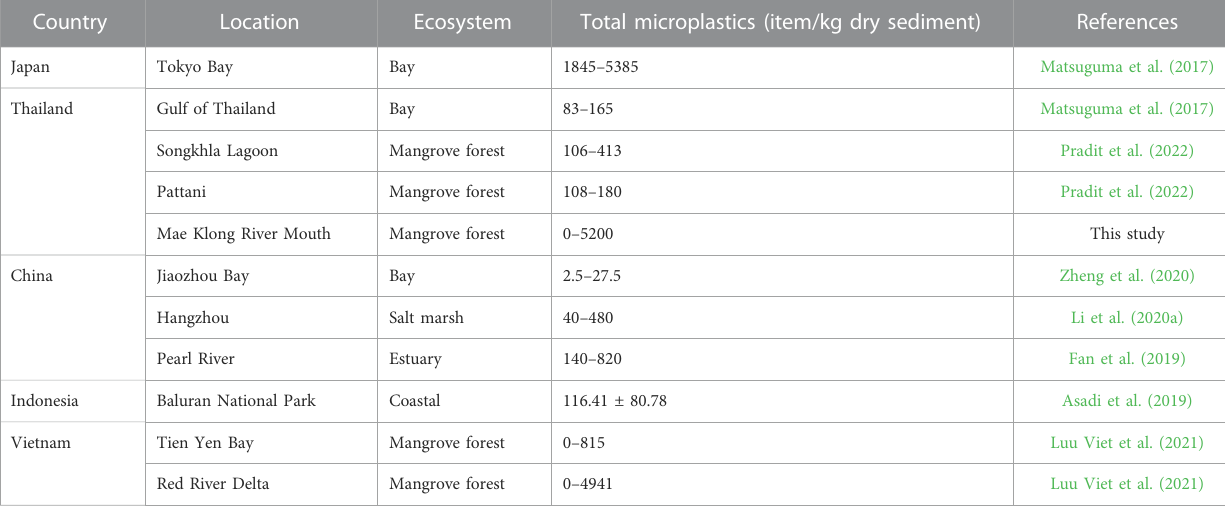
TABLE 1 The abundance of microplastic in sediment cores from this study and selected regions. Country